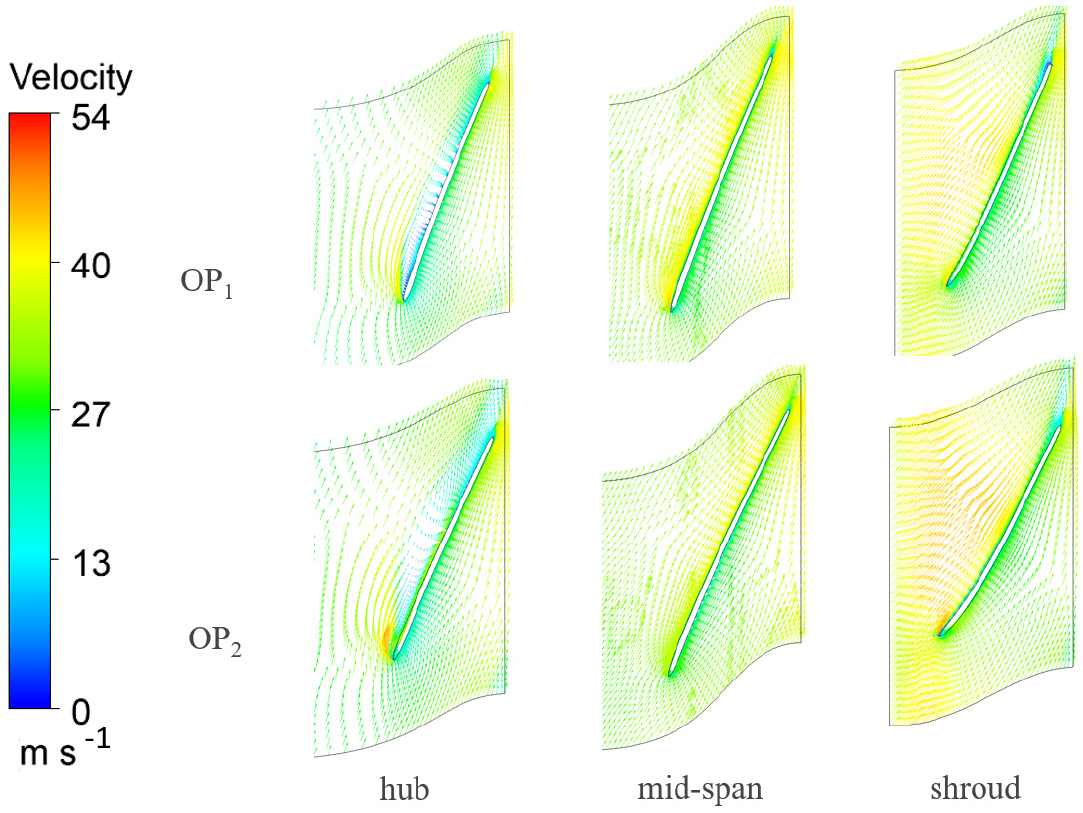
Figure 15. Optimal design relative velocity vector at OP 1 and OP 2.